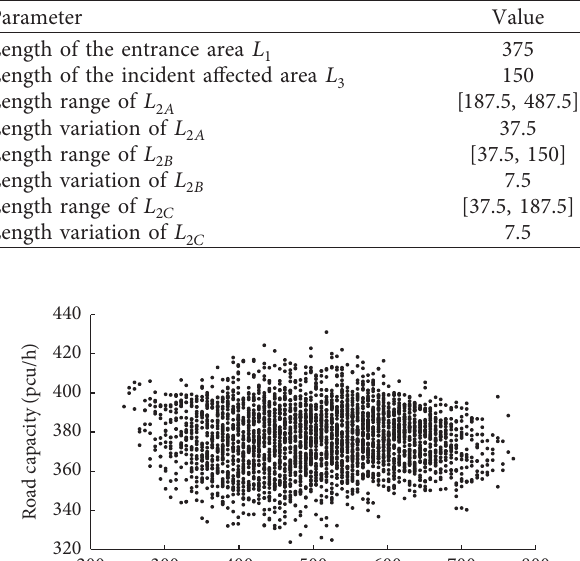
Table 2: Parameter matrix of a refined cell length (m).